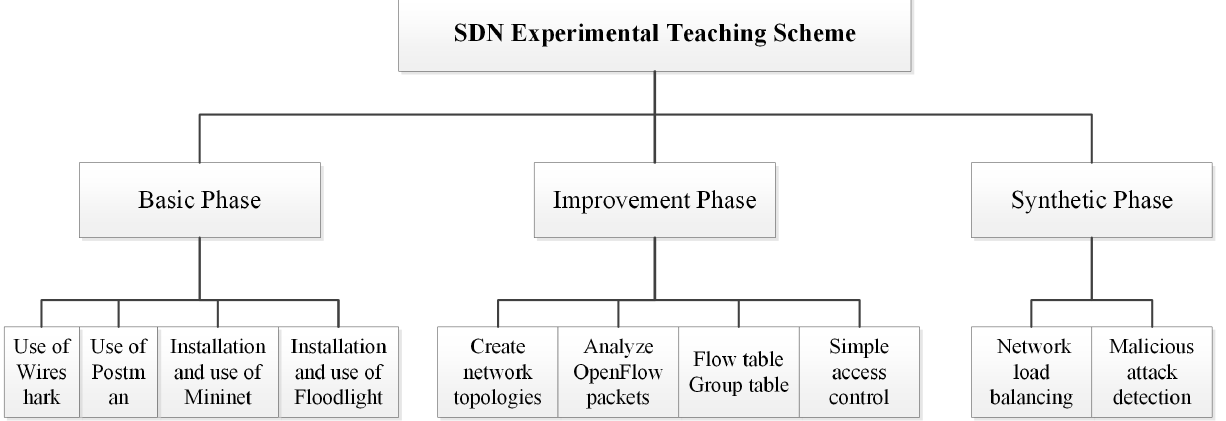
Fig. 2 The design of SDN experimental teaching scheme.